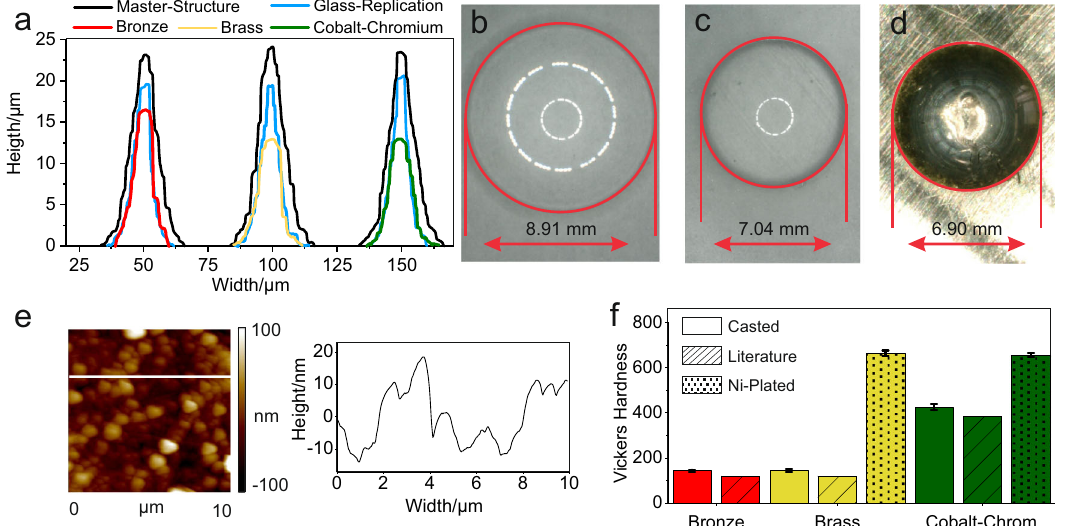
Fig. 2 | Characterization of the replicated metal moulds. a White-light inter- ferometry measurement of the generated metal inserts for bronze (red), brass (yellow), and cobalt-chromium (green). b Optical lens master structure which was used to characterize the overall shrinkage during the process. c Fused silica repli- cation of the optical lens. d Resulting cast bronze metal lens (negative). e AFM- Measurement of an unstructured casted bronze insert with a surface roughness of onlyR q 8.0nm. f Comparison of Vickers hardness valuesof manufactured samples